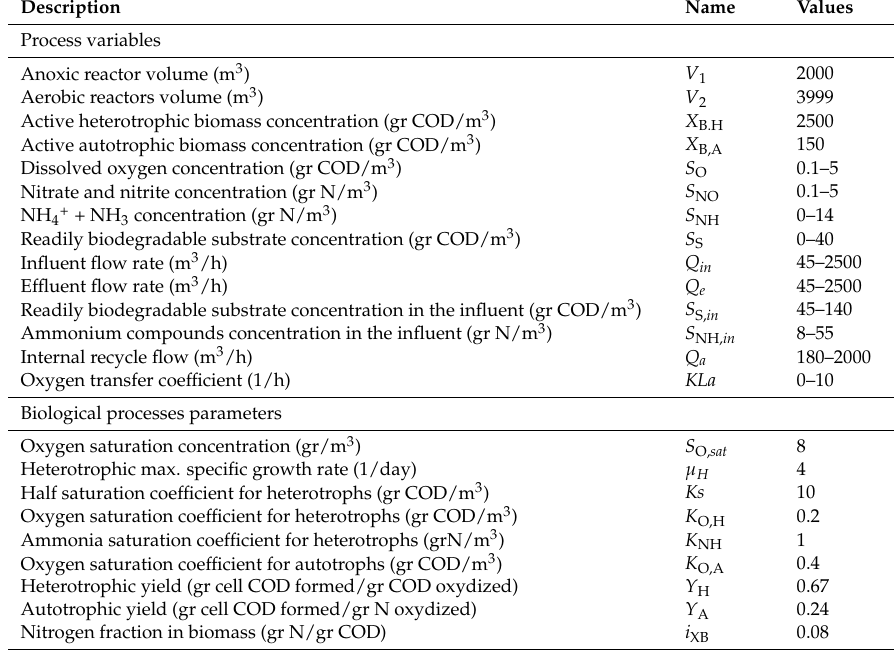
Table A1. Reduced BSM1 model variables and parameters for a temperature close to T = 15 ◦